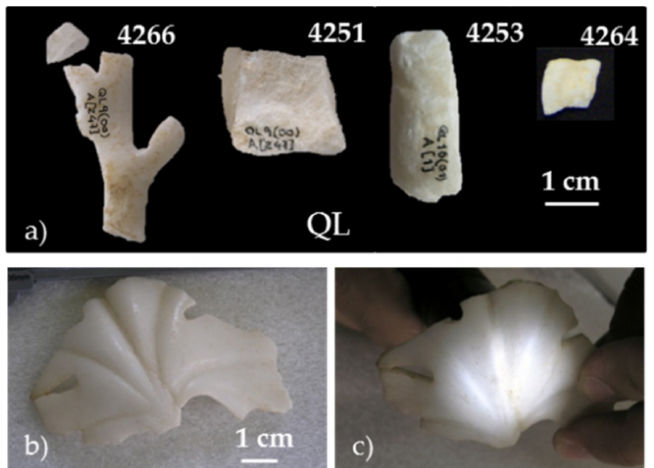
Figure 3. Small fragments of the same sculptural program: ( a ) selected pieces for analyses (QL); ( b ) given this statuary marble’s high quality, brilliance and superficial fineness for carving, it could be mistaken for a piece of ivory; ( c ) it has a high transmittance for light. Photographs by M.P. Lapuente